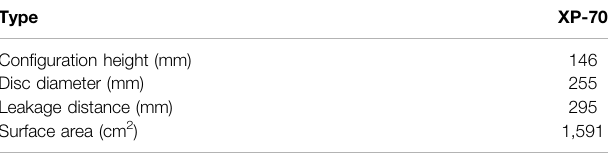
TABLE 1 | Structure fi gure and parameters of the XP-70 insulator. Type